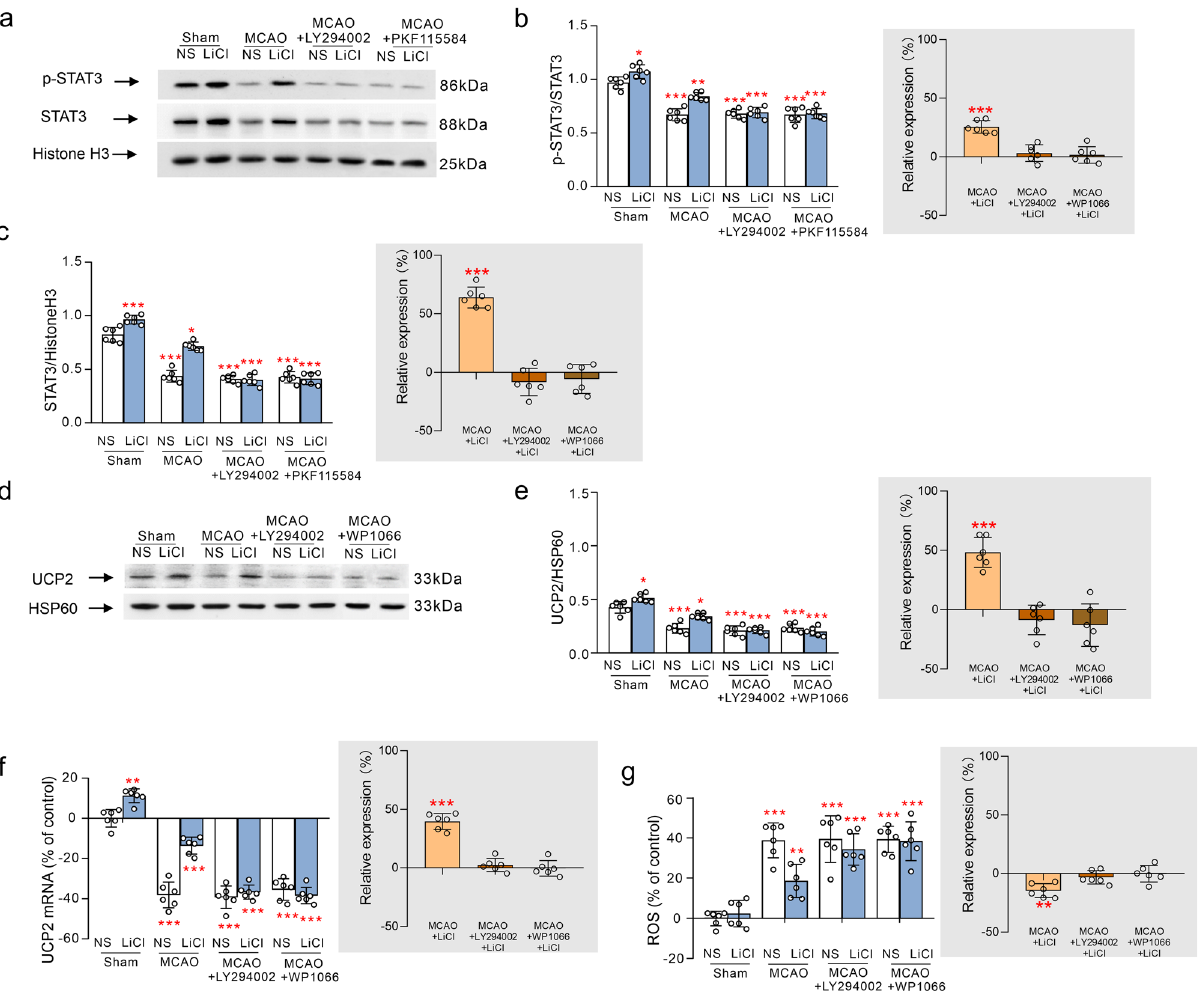
Fig. 5 The regulations of Li + in the nuclear levels of STAT3 and the mitochondrial levels of UCP2 and ROS following ischaemia-reperfusion. a The representative protein bands of p-STAT3, STAT3 and Histone-H3 (the house-keeping protein) in the nucleus. The phosphorylation ratio of p-STAT3 and STAT3 is shown in b , and the normalised intensities of STAT3 by Histone H3 were shown in c , the right inserts were the relative comparison with the respective MCAO-NS groups. d The representative protein bands of UCP2 and HSP60 (the house-keeping protein) in mitochondrion. The intensity ratio of UCP2 and HSP60 was shown in e , and the right insert was the relative comparison with the respective MCAO-NS groups. f The relative mRNA expressional ratio of UCP2 normalised by GAPDH (the house-keeping gene). g The ROS level normalised to control group. The protein levels were calculated and plotted as mean ± SD. N = 6 per group. Two-way ANOVA for comparisons including more than two groups; unpaired two-tailed t -test for two group comparisons. * p < 0.05, ** p < 0.01, *** p